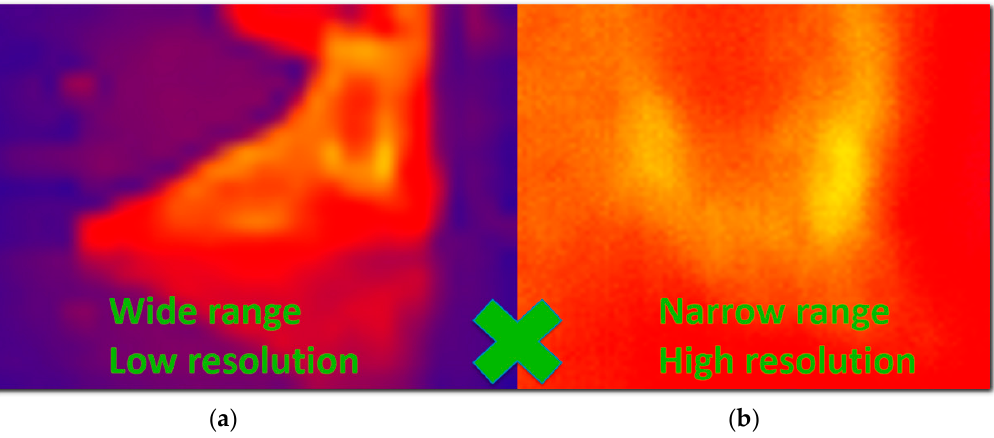
Figure 3. The impossibility of simultaneously reaching both a wide range and a high resolution restrains the use of thermal imaging in medicine: ( a ) in a wide-range view, the whole body part is visible, but the details of the temperature distribution are not; ( b ) in a narrow-range view, the details are visible, but the region cannot be localized, and context characterizing the whole affected area is missing.